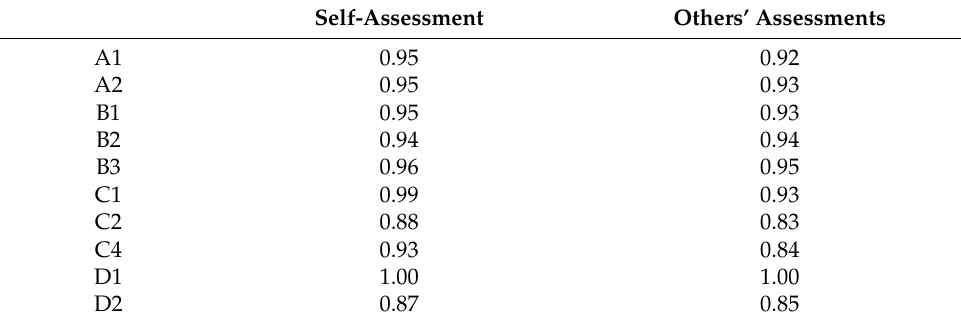
Table 2. Cronbach’s α coefficient for each scale of the UNNAN ladder.